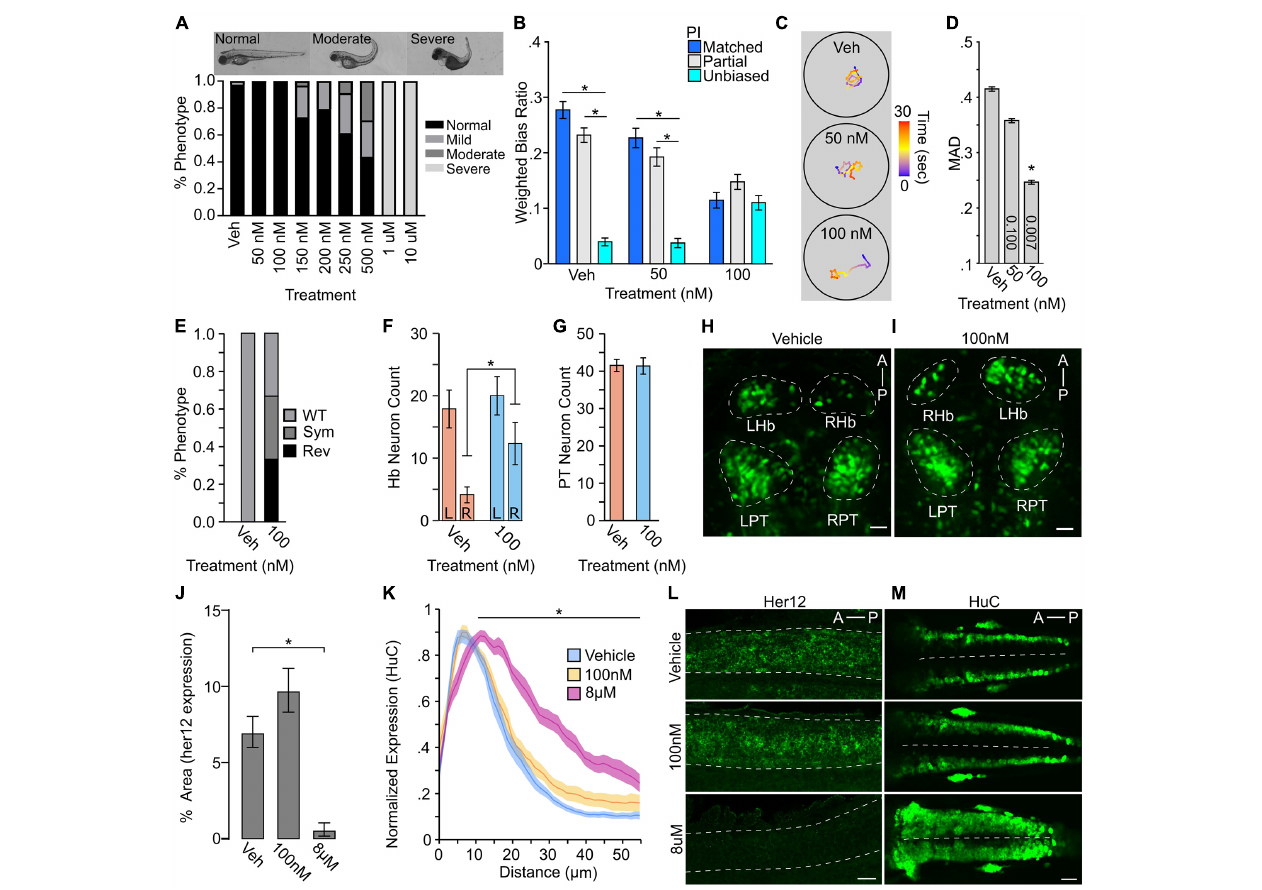
FIGURE 5 | Turn bias is sensitive to levels of Notch signaling. (A) Phenotypic counts following Notch inhibitor treatment (Vehicle, N = 125; 50 nM, N = 88; 100 nM, N = 114; 150 nM, N = 123; 200 nM, N = 120; 250 nM, N = 101; 500 nM, N = 48; 1 µ M, N = 43; 10 µ M, N = 100). (B) Weighted absolute bias ratio averages (matched PI = 0,1 blue bar; Partial match PI = 0.25, 0.75 gray bar; unbiased PI = 0.50 cyan bar. (C) Illustrative traces for treatment groups. Scale bar color represents time in seconds. (D) Effect of Notch inhibition on MAD. p -values shown in bar, 1-way comparison of treatment groups to control. (E) Habenula symmetry for vehicle controls ( N = 8) and 100 nM Notch inhibitor treated ( N = 9) larvae showing proportion with WT, symmetric (Sym), or reversed (Rev) phenotypes. WT larvae have the larger habenula in the left hemisphere. y279 neuron counts in the habenula ( F: vehicle N = 8; 100 nM N = 9) and PT ( G: vehicle N = 8; 100 nM N = 9). For neuron counts, regardless of hemisphere the larger habenula was classified as the ‘left’ habenula. (H,I) Representative maximum projection images showing y279 labeled neurons in vehicle and control. Scale bar 20 µ m. (J) Area of her12 expression in the spinal cord following LY411575 treatment (Vehicle, N = 12; 100 nM, N = 13; 8 µ M, N = 11). (K) Normalized distribution of HuC/D positive neurons following notch inhibition (Vehicle: Blue, N = 18; 100 nM: Yellow, N = 13; 8 µ M: Magenta, N = 13). X -axis distance spans half the spinal cord (0 micron = lateral spinal cord; 55 micron = spinal cord midline). Comparison shown is between vehicle and 8 µ M along the whole length of black bar between matched positions. Ribbons ± SEM. (L) Representative images of her12 expression in 27 hpf embryos. Lateral view of spinal cord (dotted outline). Scale bar 20 µ m. (M) Representative HuC labeling in 24 hpf embryos showing dorsal view. Dotted line denotes spinal cord midline. Scale Bar 40 µ m. Asterisk p <